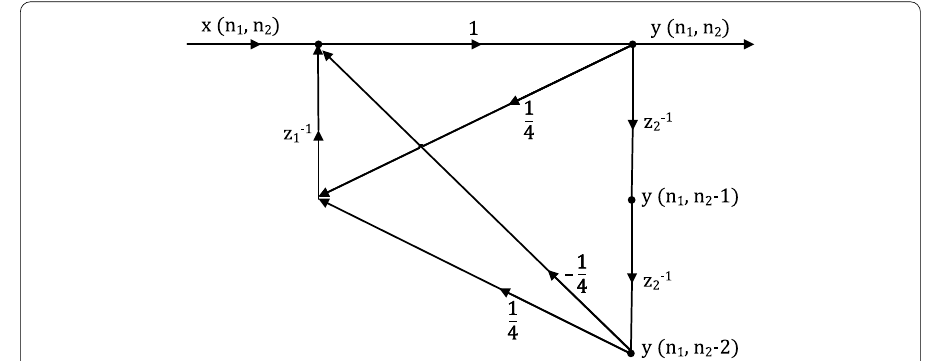
Fig. 3 Flow graph of a specialized second-order image processing